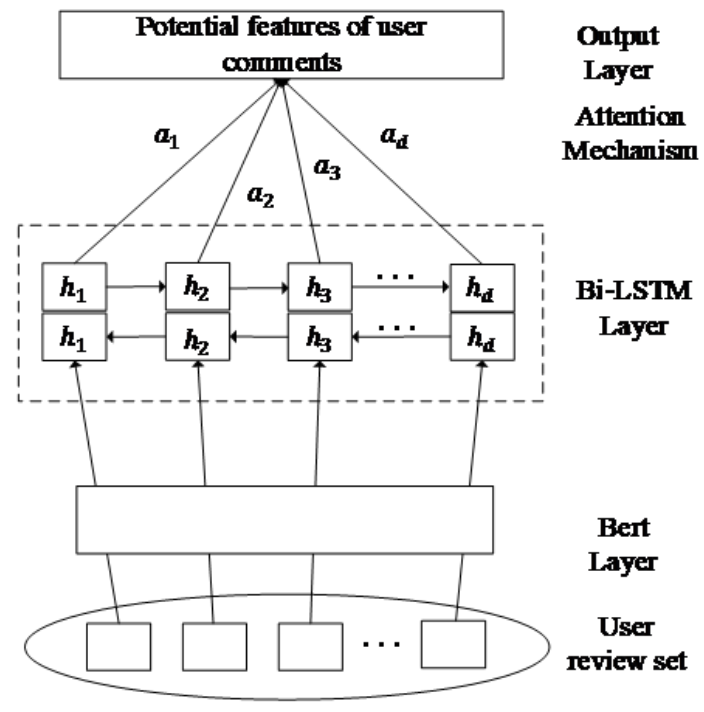
Fig. 4 User comment text